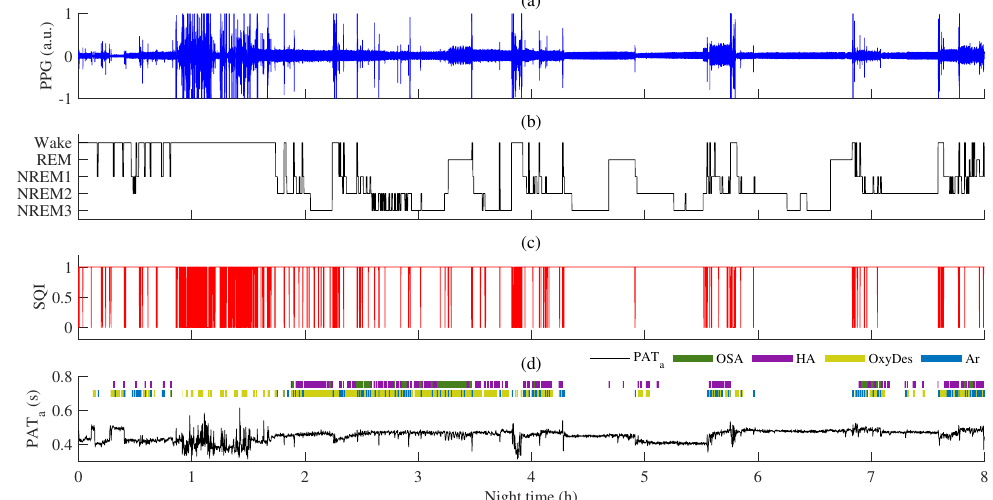
Figure 11. An example of PAT variations in different sleep stages: ( a ) PPG signal; ( b ) recorded hypnogram during PSG; ( c ) PPG signal quality estimated by the ECG-guided algorithm, SQI (SQI = 1— high-quality, SQI = 0—low-quality); ( d ) PAT after post-processing, PAT a , with annotated obstructive sleep apnea (OSA), hypopnea (HA), oxygen desaturation (OxyDes), and arousal (Ar)